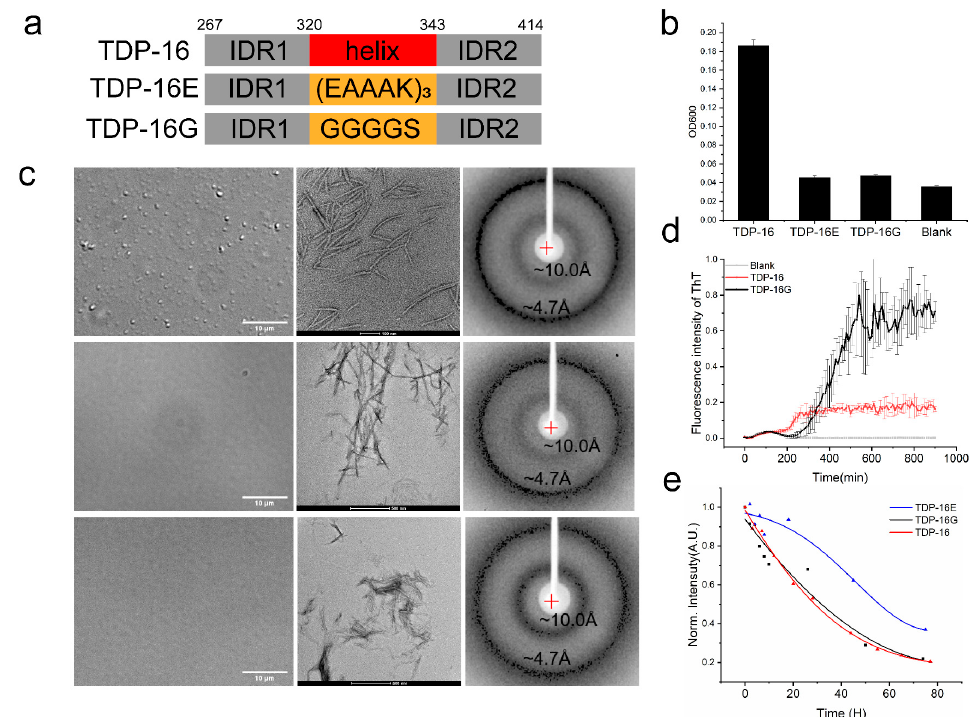
Figure 5. The function of the helical region of TDP-43 LCD in liquid–liquid phase separation and fibrillation. The protein was at a concentration of 20 μ M in pH 6.0, 10 mM phosphate buffer for all samples. ( a ) Schematic representation of three domains of TDP-43 LCD (also known as TDP-16) and its mutants TDP-16E and TDP-16G. The helical domain was replaced by (EAAAK) 3 , a rigid helical sequence; for TDP-16E, the helical domain was replaced by GGGGS, a flexible disordered linker, for TDP-16G. ( b ) Turbidity (OD600 values) of the freshly prepared wild-type TDP-43 LCD and its mutants in PB buffer. Error bars represent the SD of three replicates. ( c ) Liquid–liquid phase separation of freshly prepared TDP-16, TDP-16E, and TDP-16G was imaged by DIC microscopy. The amyloid fibrils that formed were imaged by negative-staining TEM and identified by XRD. The fibrils were collected for study after 4 days of incubation of the protein solution. ( d ) The growth rate of the TDP-16 and TDP-16G fibrils monitored by THT fluorescence. Error bars represent the SD of three replicates. ( e ) Aggregation rate of TDP-16, TDP-16E, and TDP-16G monitored by the protein’s intrinsic